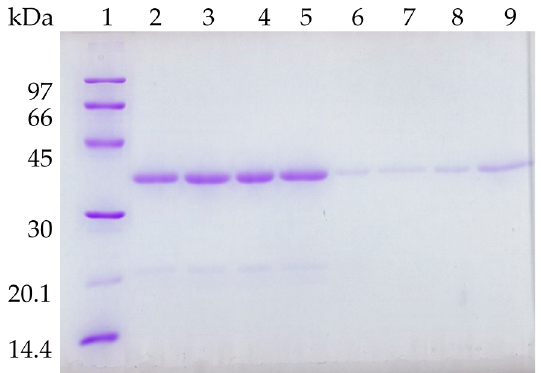
Figure 6. SDS-PAGE analysis of OCCALB and OCCALB-PEI derivatives with organic solvents. Lane 1: low molecular weight protein standard from GE Healthcare. Lane 2: OCCALB; lane 3: OCCALB-PEI; lane 4: OCCALB and lane 5: OCCALB-PEI incubated in 90% dioxane; lane 6: OCCALB and lane 7: OCCALB-PEI incubated in 70% ethanol; lane 8: OCCALB and lane 9: OCCALB-PEI incubated in 45% acetonitrile.